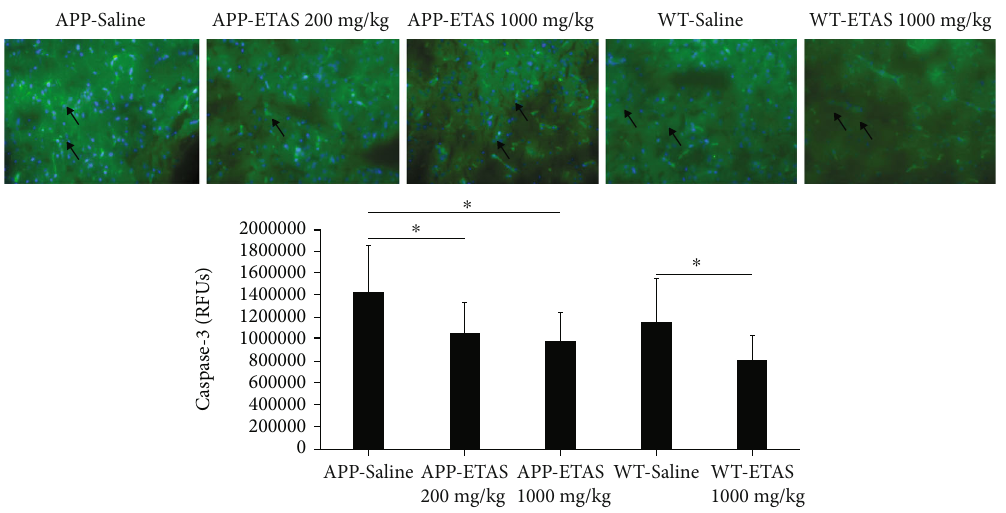
Figure 8: Quanti fi cation of caspase-3 in the hippocampus of APP-overexpressed mice treated with ETAS (200mg/kg and 1000mg/kg) and WT mice treated with ETAS (1000mg/kg) for 1 month, respectively. ∗ p < 0 : 05 APP-ETAS (1000mg/kg and 200 mg/kg) vs. APP saline- treated mice; ∗ p < 0 : 05 WT-ETAS (1000mg/kg) vs. WT saline-treated mice; RFUs: relative fl uorescence units. Four mice per group and four sections per mouse were used; green represents capase-3 protein, and blue represents DAPI. Arrows represent fl uorescent green staining, indicating positive expression. Magni fi cation is represented ×